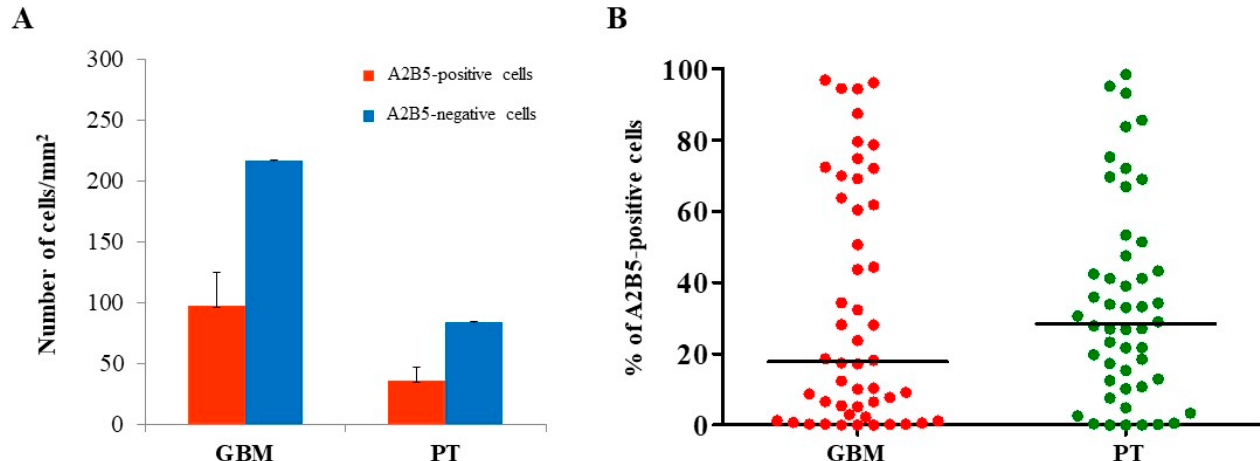
Figure 4. Stereological analysis of A2B5 expression in both GBM and PT areas. To more accurately evaluate the immunohistochemistry results, an unbiased stereological technique was used. Within each selected region of interest (ROI), the number of both immunopositive and immunonegative cells were used to estimate the expression density of A2B5 in the indicated histological areas. ( A ) Red and blue bars show the number of A2B5-positive and A2B5-negative cells/mm 2 , respectively. The data are presented as the mean ± SE. ( B ) Plots show the percentage of A2B5-positive cells in GBM and PT areas. N = 50; the horizontal line represents the median value; p indicates the result of the Mann-Whitney test.